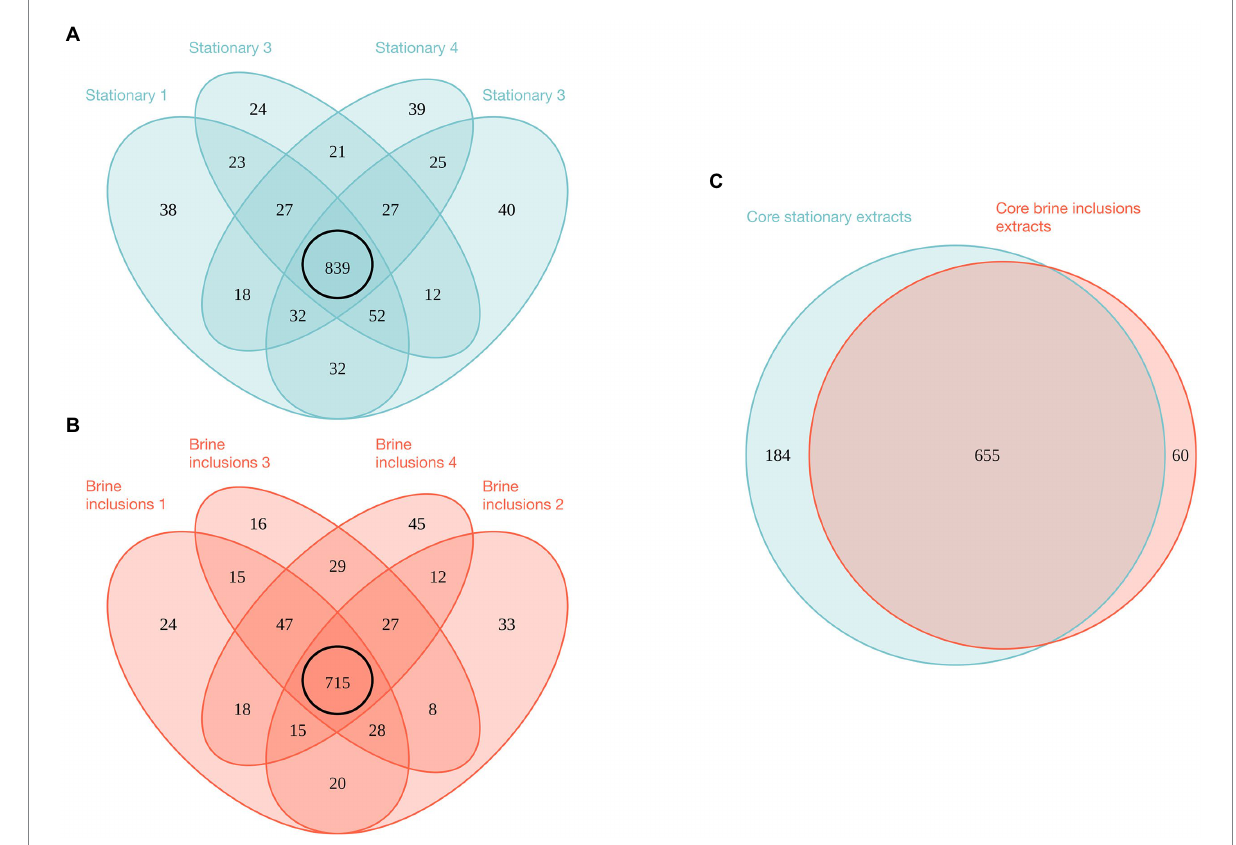
FIGURE 4 Venn diagrams of proteins identified by mass spectrometry for brine inclusions and liquid stationary culture samples. (A) Comparison of biological replicates for liquid stationary culture extracts. (B) Comparison of biological replicates for brine inclusions extracts. Black circles in (A,B) represent “core” proteins shared by the four replicates in both cases. (C) Comparison of core proteins between brine inclusion extracts and liquid stationary culture